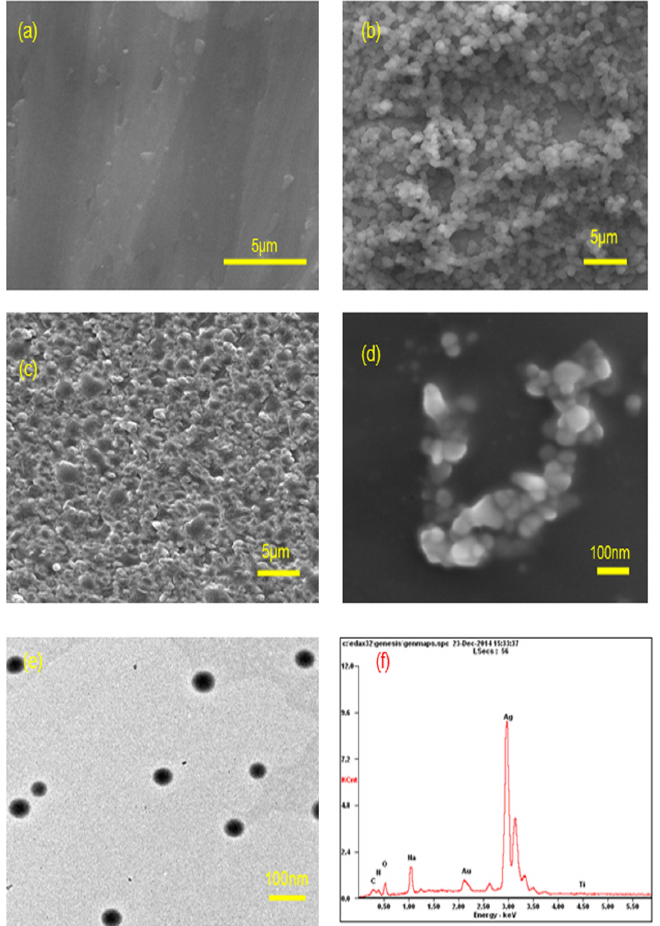
Fig 3. SEM images of surface morphology of Ti discs: (a) pristine Ti, (b) Ti-PTL, (c) Ti-PTL-HA, (d) Ti- PTL-HA-CS/Ag10. (e) TEM image of CS/Ag (10mM). (f) EDX image of the sample of Ti-PTL-HA-CS/Ag.